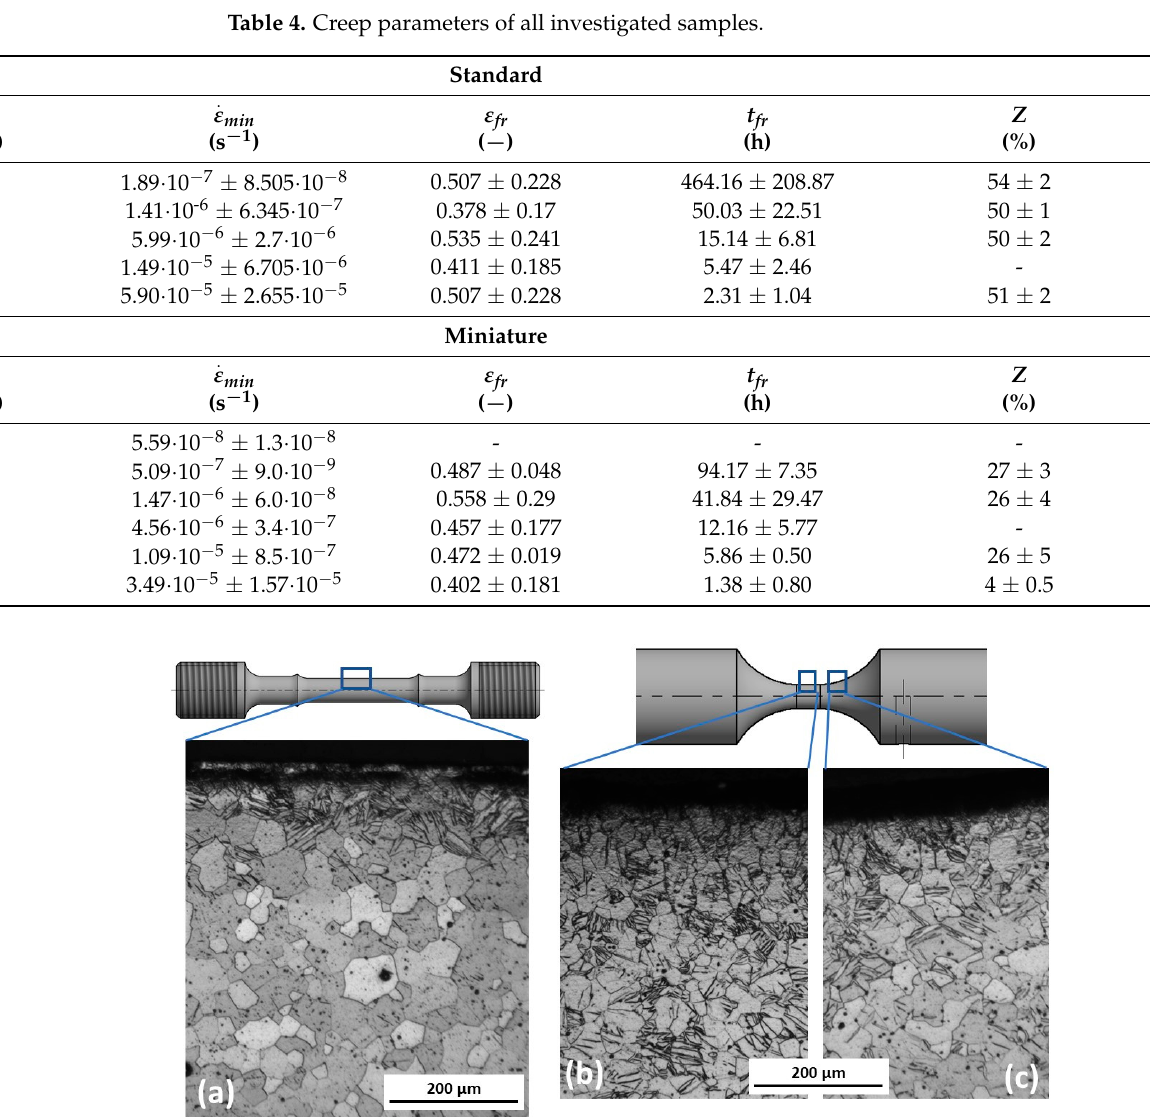
1.5 ( σ = 15 MPa), 1.8 ( σ = 20 MPa) to a maximum of 1.9 ( σ = 30 MPa)